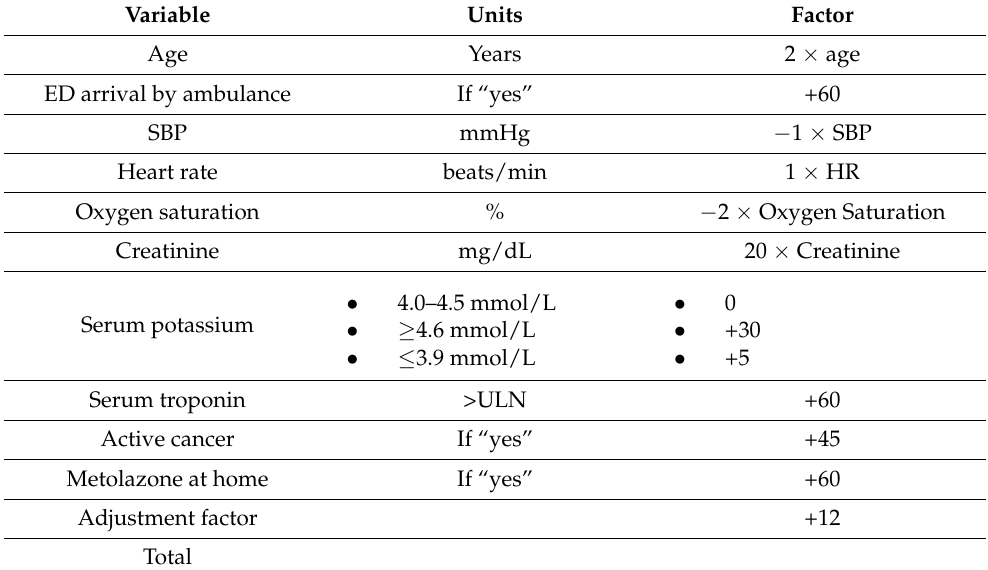
Table 1. EHMRG Score.